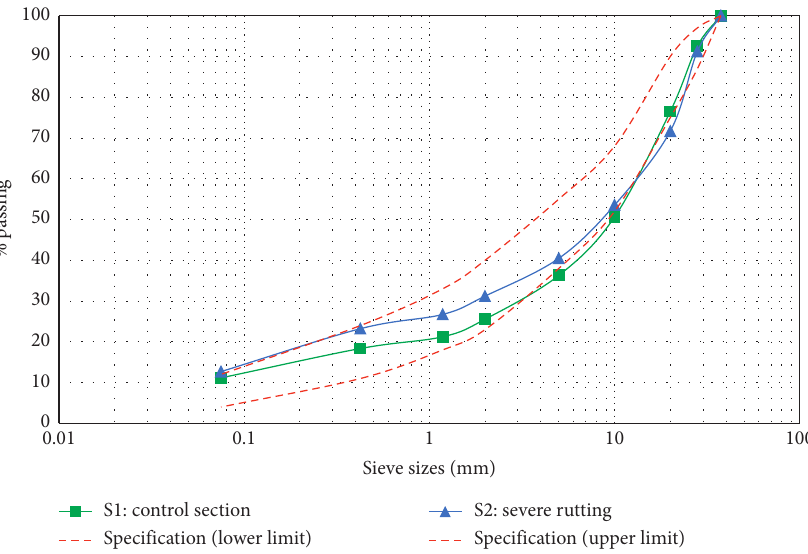
Figure 6: Particle size distribution—base course.